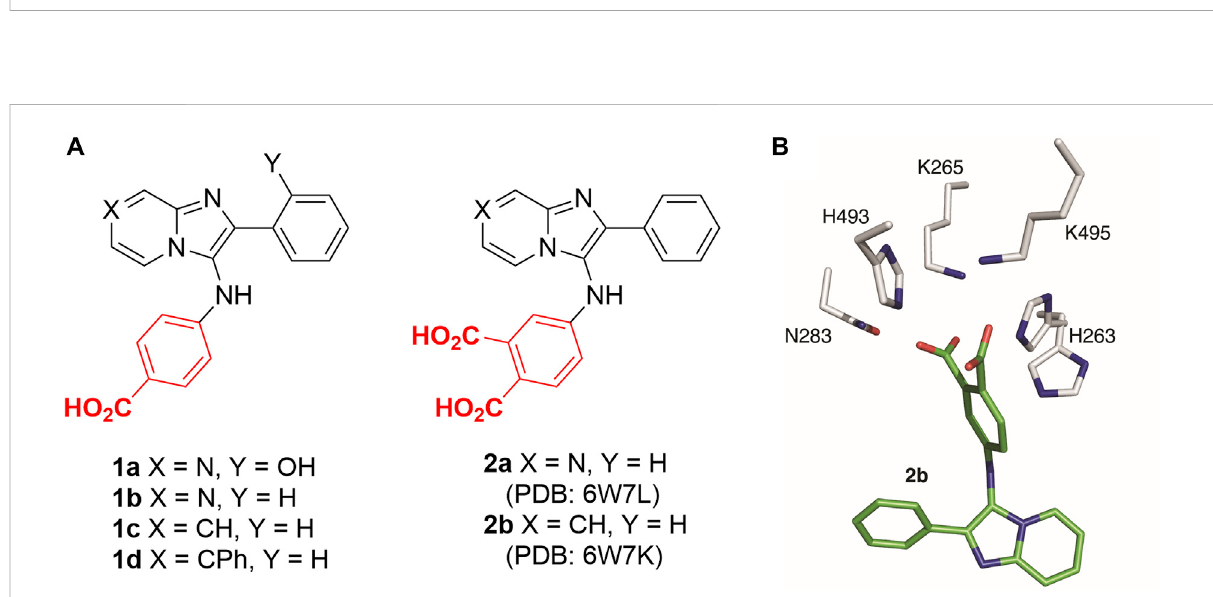
FIGURE 2 StructuresofTDP1inhibitorsandthebindingmode. (A) Structuresofimidazopyrazineandimidazopyridine-basedTDP1inhibitors. (B) Structure of TDP1 active site with highlighted catalytic residues (gray) complexed to the TDP1 inhibitor imidazopyridine 2b (carbon atoms in green; PDB code: 6W7K (Zhao et al., 2021)).